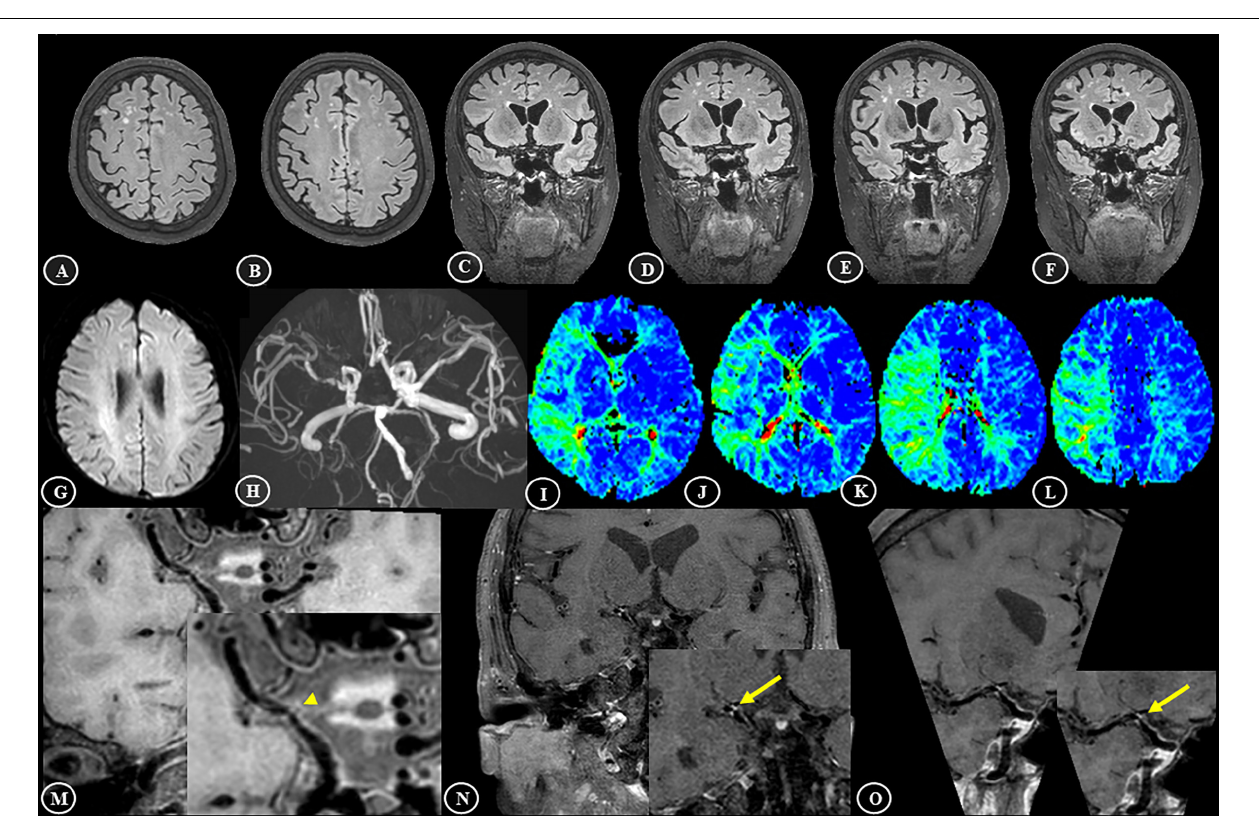
FIGURE 3 | Bar graphs showing the relationship between DWMH volume ipsilateral to the ICAS site and the status of hypertension (A) . Scatter plots showing the relationship between DWMH volume ipsilateral to the ICAS site and TTP-ASPECTS (B) and age (C) . WMH volume was log-transformed to normalize the distribution.